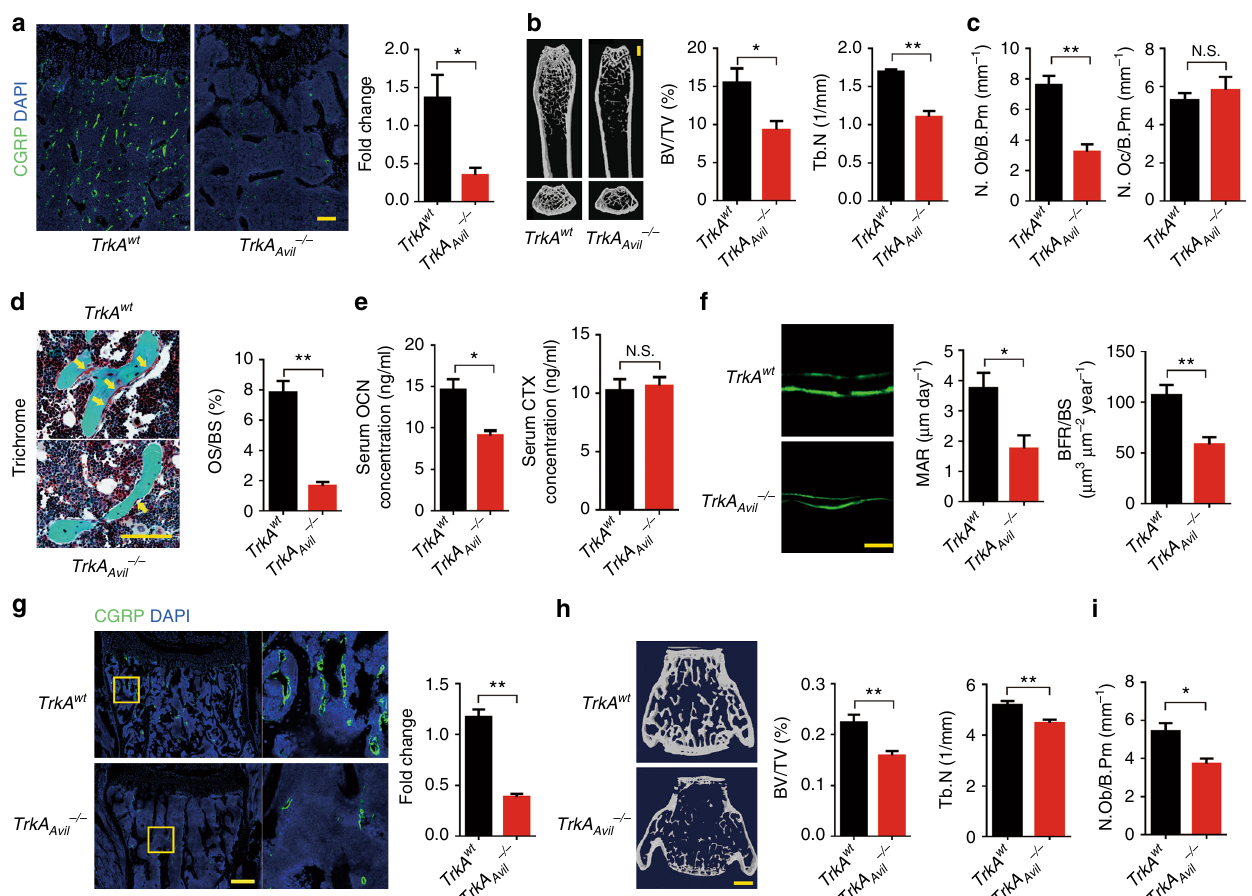
Fig. 1 Osteoblastic bone formation is reduced without sensory nerve innervation. a Representative images of immuno fl uorescence staining and quantitative analysis of the CGRP + sensory nerves (green) in the femurs of 12-week-old TrkA wt and TrkA Avil − / − mice. DAPI stains nuclei blue. Scale bar: 100 μ m. b Representative micro-computed tomography ( μ CT) images of femurs from 12-week-old male TrkA wt and TrkA Avil − / − mice. Quantitative analysis of trabecular bone fraction (Tb. BV/TV) and trabecular number (Tb. N). Scale bar: 1 mm. c Histomorphological analysis of osteoblast (N.Ob/B.Pm) and osteoclast (N.Oc/B.Pm) numbers on the trabecular bone surface of femurs of 12-week-old TrkA wt and TrkA Avil − / − mice. d Trichrome staining and quantitative analysis of osteoid surface per bone surface (OS/BS) in femoral bone tissue from 12-week-old TrkA wt and TrkA Avil − / − mice. Scale bar, 50 μ m. e ELISA analysis of serum OCN and CTX levels in 12-week-old TrkA wt and TrkA Avil − / − mice. f Representative images of calcein double labeling of trabecular bone of femurs with quanti fi cation of mineral apposition rate and bone formation rate in 12-week-old TrkA wt and TrkA Avil − / − mice. Scale bar, 20 μ m. g Representative images of immuno fl uorescence staining and quantitative analysis of the CGRP + sensory nerves (green) in the vertebrae of 12-week-old TrkA wt and TrkA Avil − / − mice. DAPI stains nuclei blue. Scale bar: 100 μ m. h Representative μ CT images of vertebra from 12-week-old TrkA wt and TrkA Avil − / − mice. Quantitative analysis of trabecular bone fraction (Tb. BV/TV) and trabecular number (Tb. N). Scale bar: 1 mm. i Histomorphological analysis of osteoblast (N.Ob/B.Pm) numbers on the trabecular bone surface of 12-week-old TrkA wt and TrkA Avil − / − mice vertebra. N ≥ 5 per group. * P < 0.05, ** P < 0.01 and N.S. means not signi fi cant. (Student t